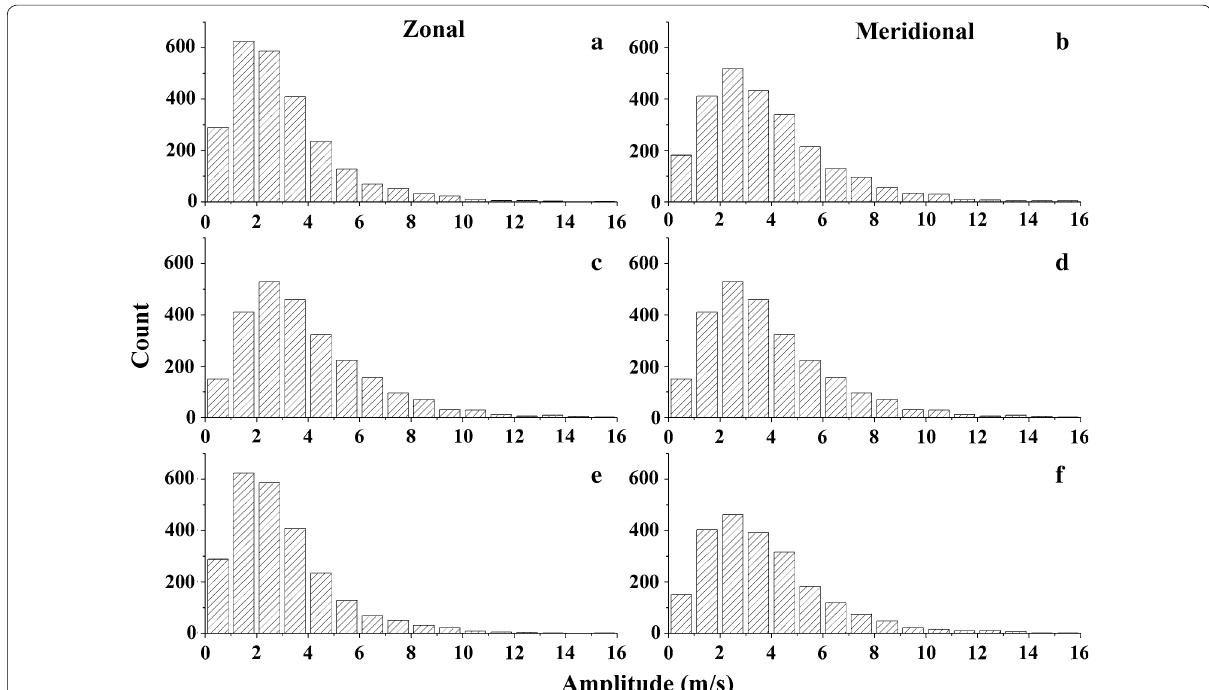
Fig. 5 Occurrence frequency of the QDT amplitude over the year for a zonal wind at CA, b meridional wind at CA, c zonal wind at CP, d meridional wind at CP, e zonal wind at SM, and f meridional wind at